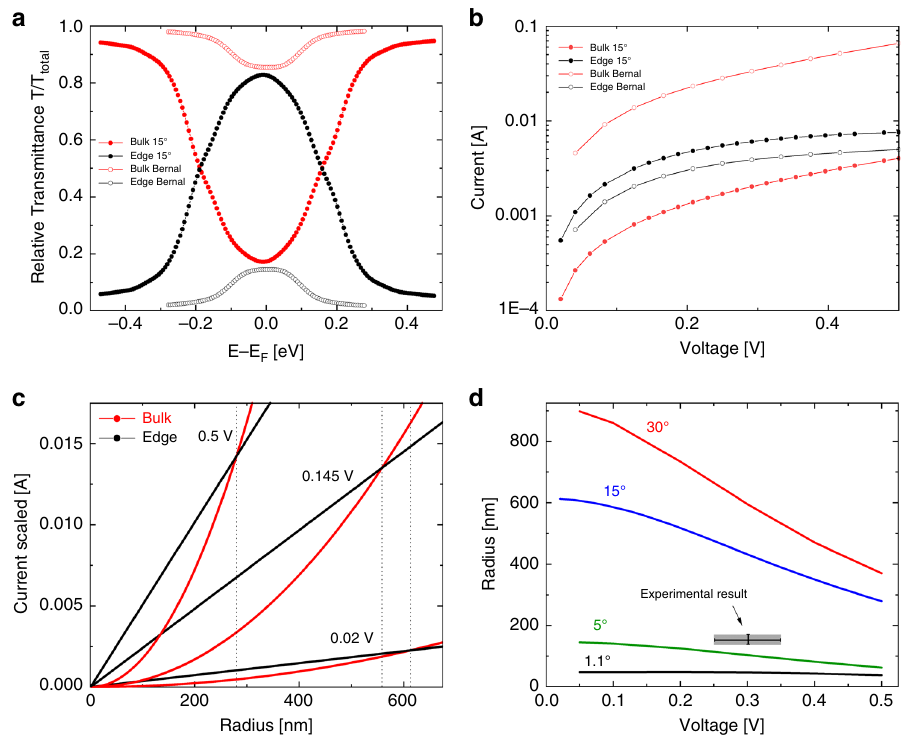
Fig. 4 Calculated interfacial transmittance, current, and edge to bulk cross-over conditions. a Calculated relative transmittance probability T E ð Þ = T total E ð Þ E ð Þ = T E ð Þ , for Bernal (empty circles) and 15° twisted (full circles) 300 nm diameter circular graphene bilayer junctions, showing separately edge ( T Edge total black) and bulk ( T Bulk E ð Þ = T total E ð Þ , red) contributions. b Calculated interlayer currents as a function of applied interlayer voltage for Bernal (empty circles) and 15° Twisted (full circles) graphene con fi gurations, showing separately edge (black, including edge-bulk contributions) and bulk (red) contributions. Both the calculated transmittance curves and the currents are scaled to mimic a 300 nm diameter circular structure with 2 nm wide edges (see main text for further details). c Calculated edge (black) and bulk (red) currents as a function of circular bilayer graphene contact radius for different interlayer bias voltage drops. The different scaling laws for edge and bulk effective areas, result in a cross-over radius in which bulk conduction takes over edge conduction (marked by the dashed vertical lines). d Cross-over radius as a function of interlayer bias voltage (edge width is considered as 2 nm) for different interlayer angular con fi gurations. Gray area marks the regime corresponding to our experimental study, i.e., contact diameter of 300 ± 10 nm and edge-to-bulk transport cross-over bias of 0.3 ± 0.05 V (see data for the 5 nm shifted junction in Fig. bias voltages. Figure 4c shows the calculated edge (black) and bulk (red) current pro fi les as a function of the contact radius for three representative bias voltages, from which we can extract the cross-over value between edge and bulk current dominance.